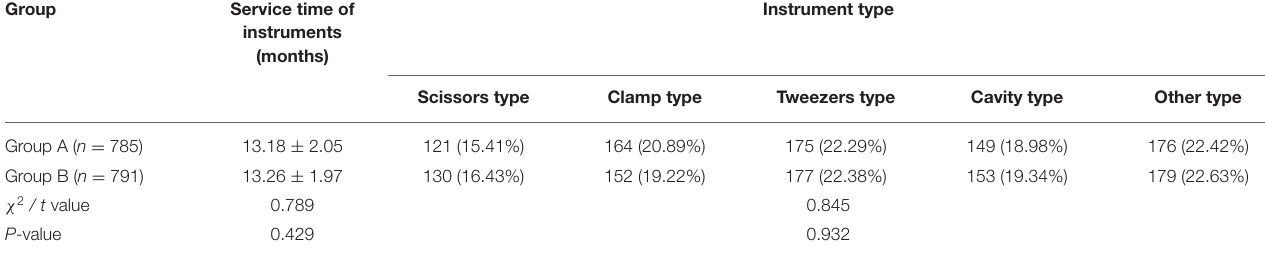
TABLE 3 | Basic information of ophthalmic precision instruments ( n , ¯ x ± s, %).